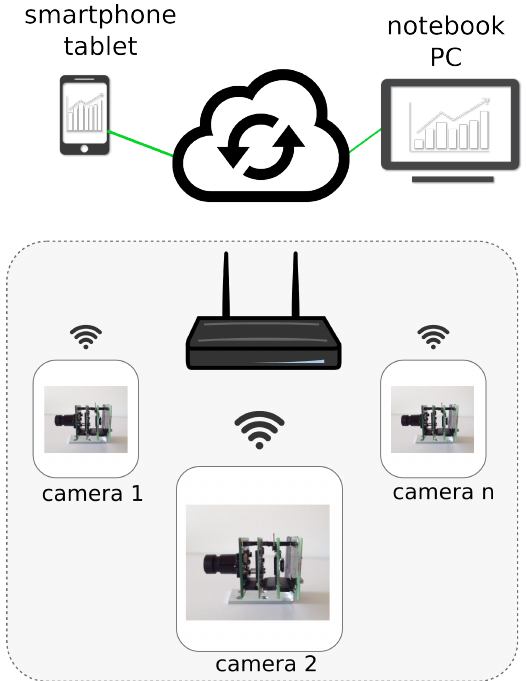
Figure 8. The sensor cloud